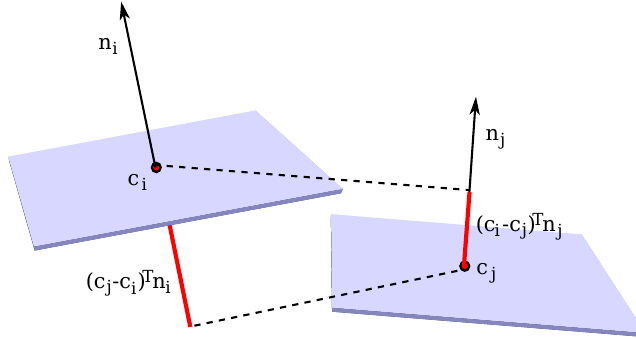
and c onto neighboring planar i j